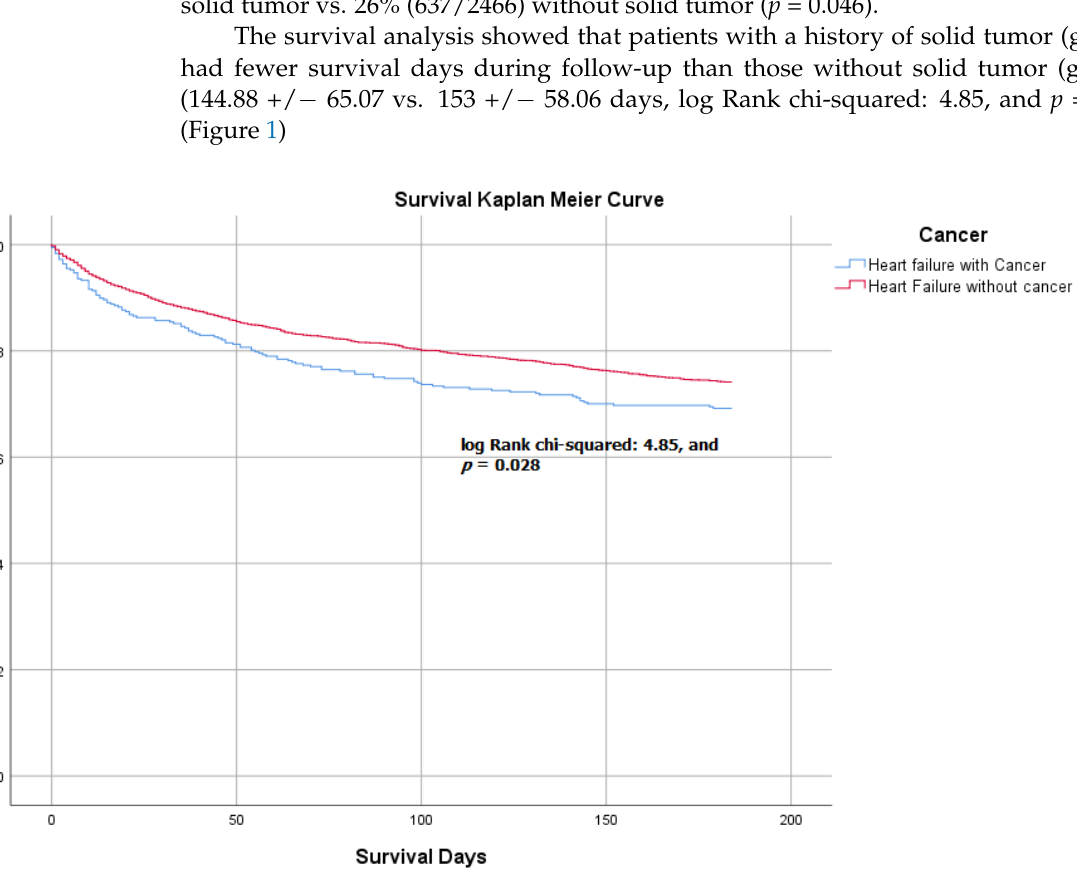
Figure 1. Kaplan–Meier survival curve between acute heart failure in patients with and without cancer.